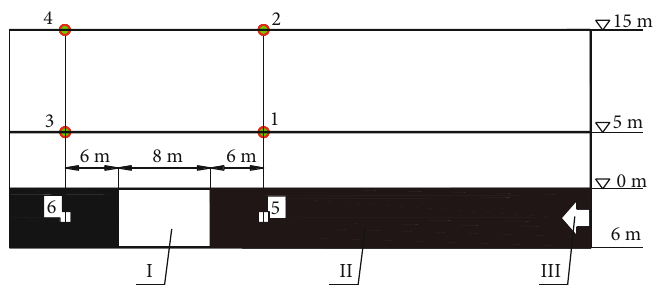
Figure 5: Measuring point locations. I — abandoned roadway; II — coal; III — advance direction.